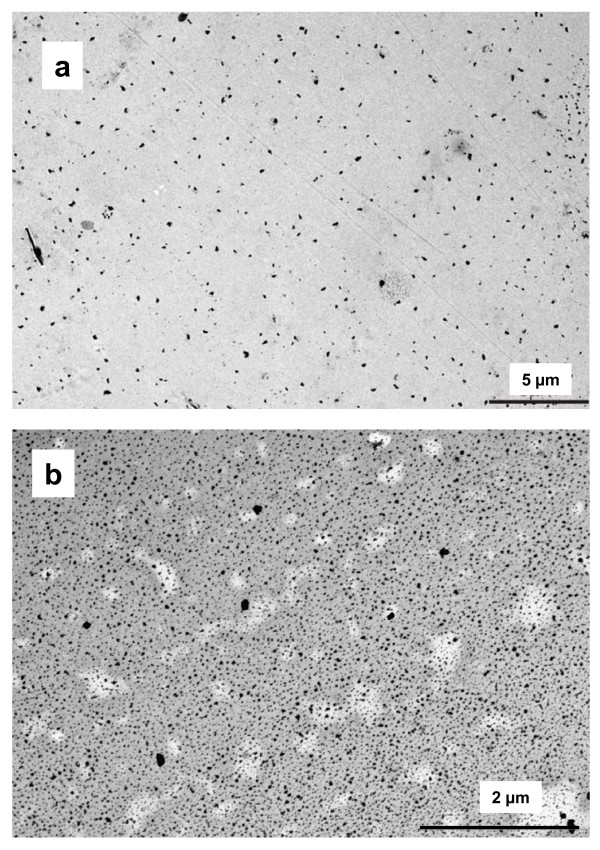
TEM micrograph of ZnO nanoparticles deposited in the ALICE. Depicted are representative micrographs obtained after nebulization of 1 mL of ZnO suspension (primary diameter 24-71 nm) with two different concentrations, a) 0.3 mg/mL and b) 7.5 mg/mL. As expected, the ZnO coverage increases with ZnO concentration and, although larger agglomerates are starting to appear for the higher concentration, their fractional contribution is still small. In both cases the deposition pattern is uniform not only on the mm scale as shown in Figure 5, but also on the scale of single droplets (micron scale). This is consistent with the formation of a continuous 14 μm liquid film after nebulization of 1 mL of suspension (estimated from deposition efficiency and chamber geometry), which implies that more than 4 droplets deposit on each location of the chamber.